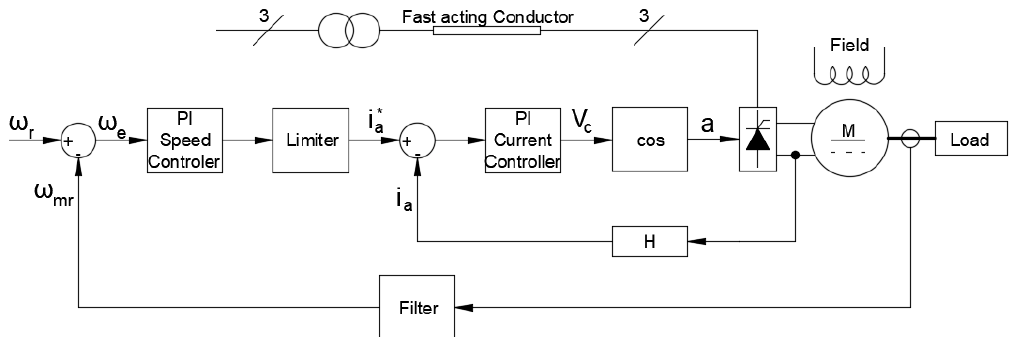
Figure 19. Speed controller two-quadrant dc motor drive [26].